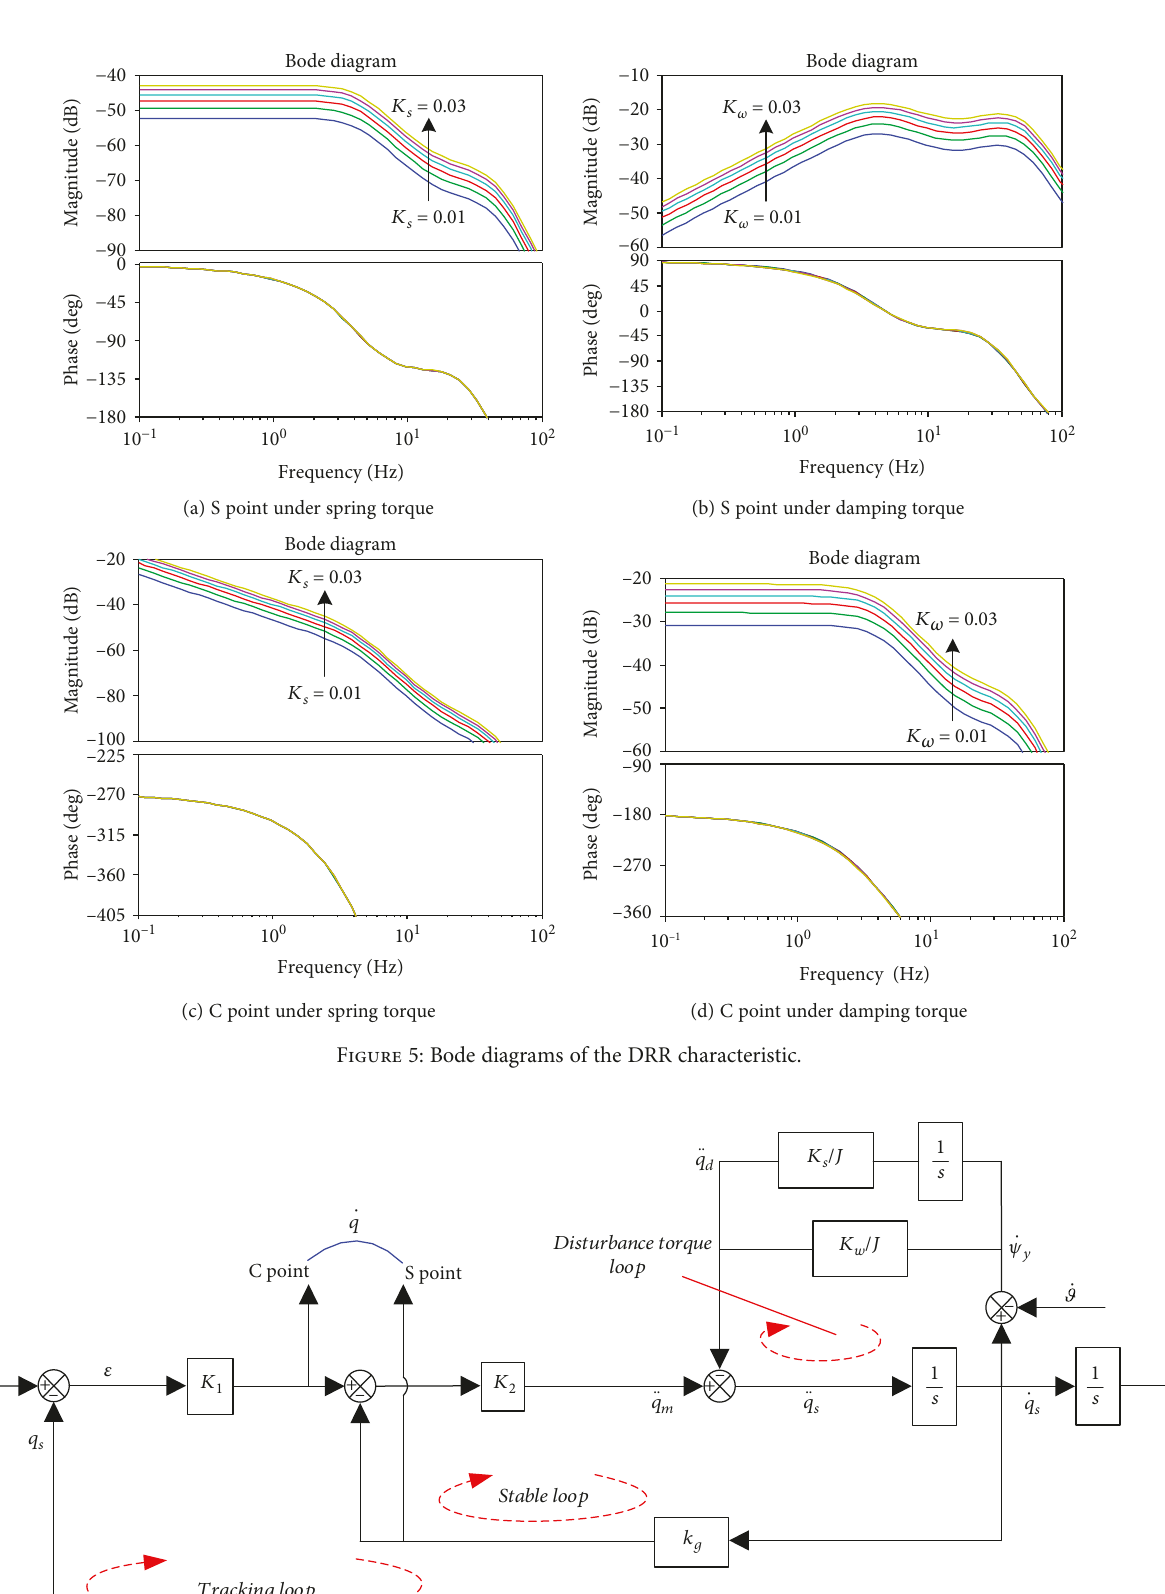
Figure 6: Equivalent block diagram of the